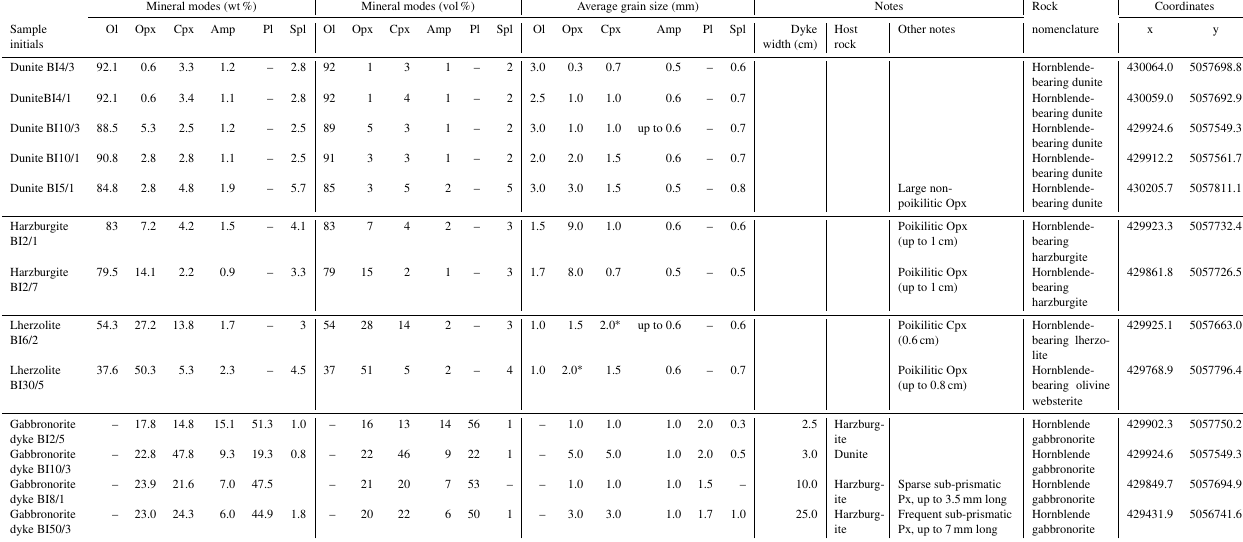
∗ Poikilitic grains are not considered in the average grain size. Table 10. Main petrographic characteristics of micro-layers occurring along the contacts between gabbronorite dykes and host peridotites. Mineral proportions were evaluated by point counting. Mineral abbreviations are after Whitney and Evans (2010), and rock nomenclature follows the classification of the International Union of Geological